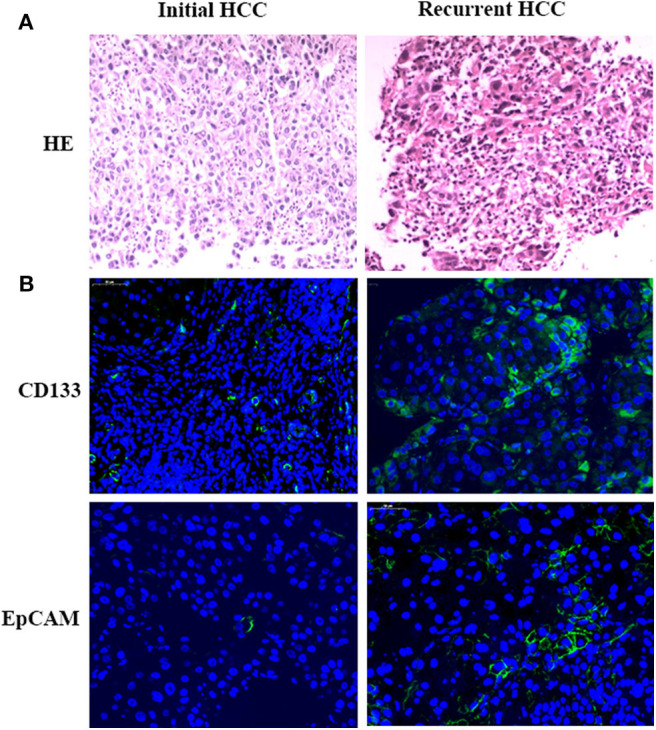
Pathological results. Tumor samples obtained from initial and recurrent HCC patients treated with RFA were examined by H&E staining. H&E staining showed the more intensive cell distribution detected in recurrent HCC compared with the initial tumor in the same patient (A). Immunofluorescence staining was used for detecting the expression of CD133 and EpCAM in HCC tumor samples (B). Positive cells were stained with green signal; nuclei were stained with DAPI (Blue). Magnification: 400×.